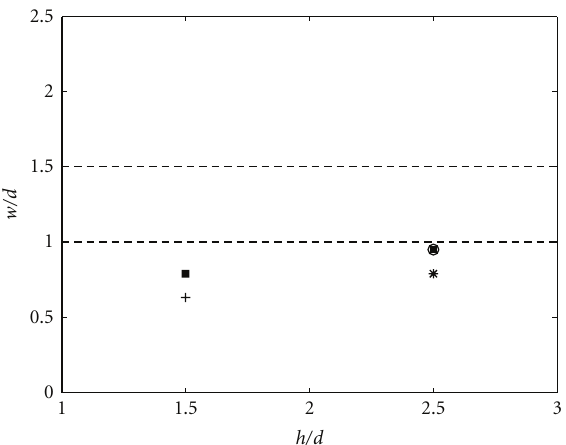
Figure 8: Canonical and live-bed results for the single pier compared with the expression by Melville et al. [25] upper and lower limits (dashed line). I = 1 . 3 no fail (black squares); I = 1 . 3